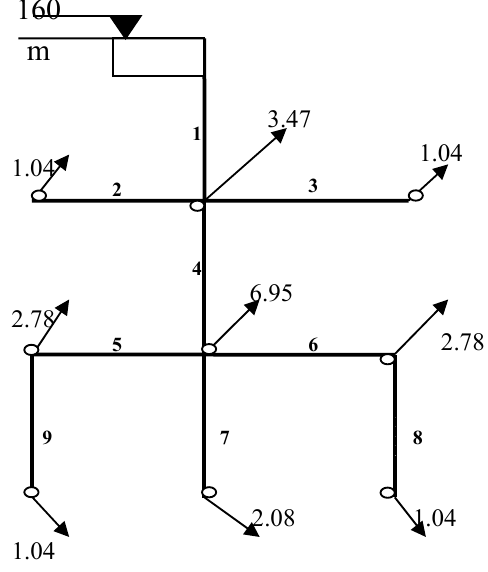
Figure 1. Water supply system schematic.